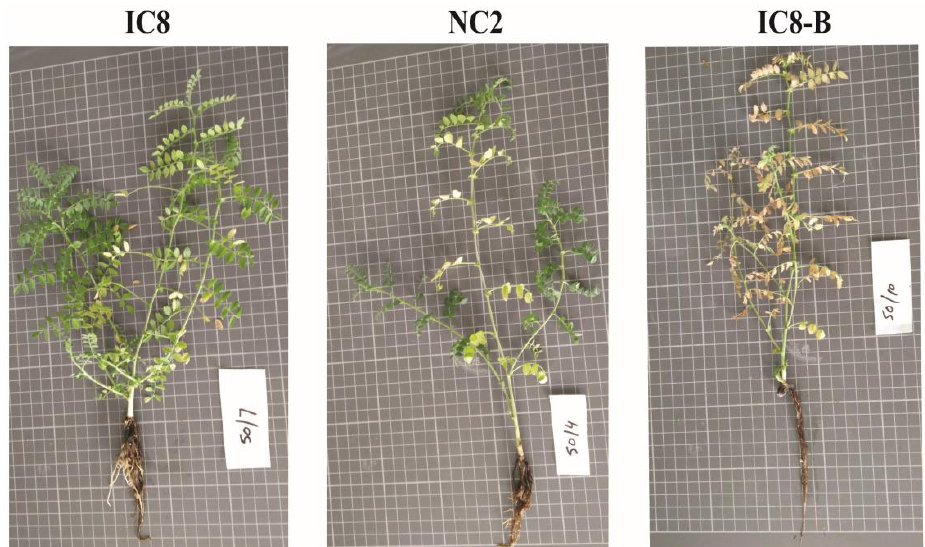
Figure 1. Chlorosis symptoms in hydroponically grown chickpea cultivars (IC8, NC2 and IC8-B) exposed to Cd2 (50 µM) after 25 days of sowing.